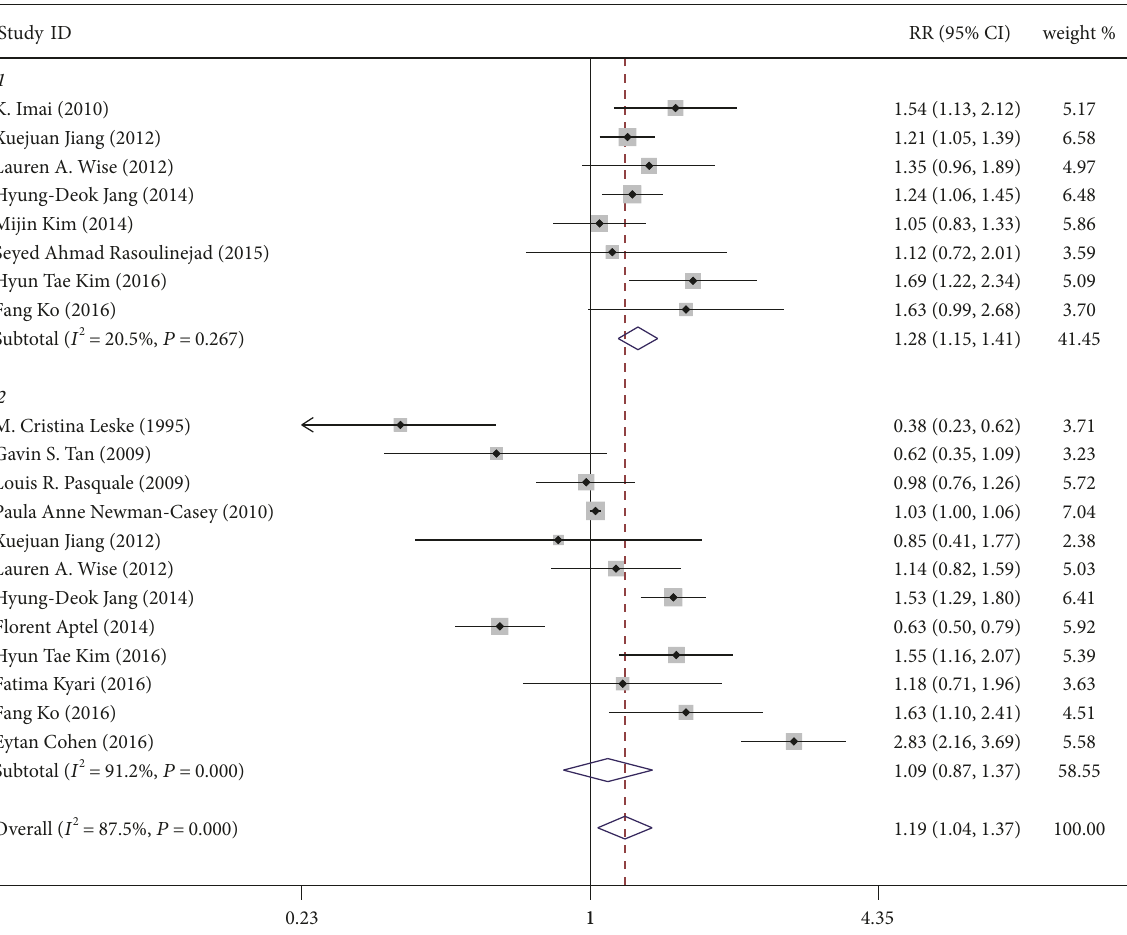
Figure 3: Forest plot for the association between general or abdominal adiposity and glaucoma. 1 =abdominal group (measured by waist circumference or waist-to-hip ratio); 2 =general group (measured by body mass index). Note: weights are from random-e ff ects